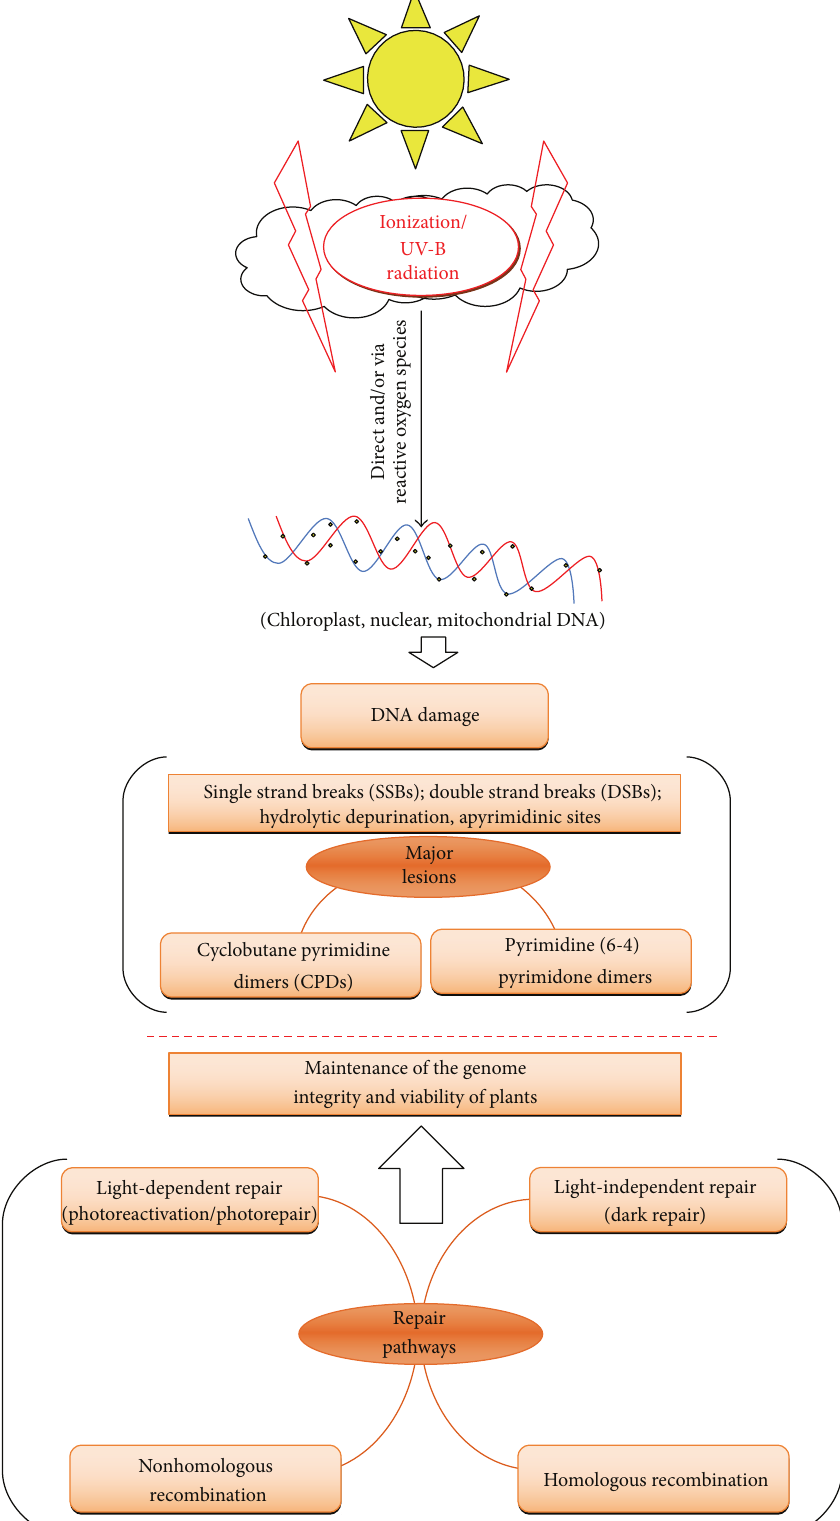
Figure 1: Mechanism of DNA damage and repair in